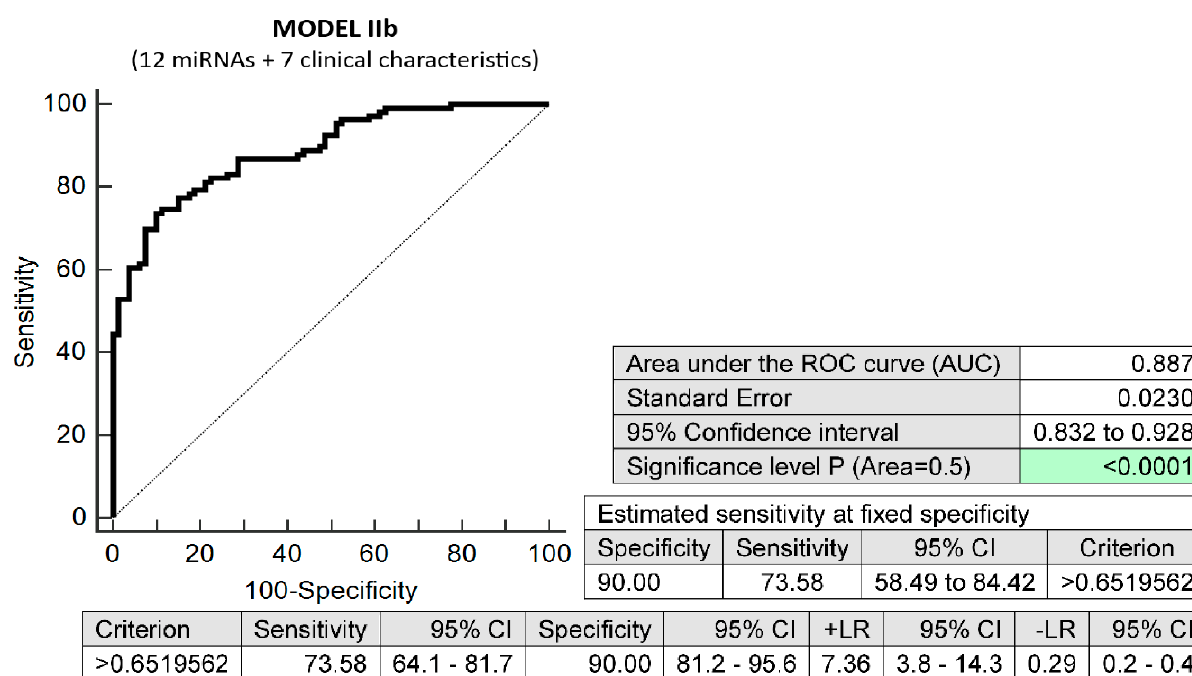
Figure 6. ROC analysis—prediction model IIb for preterm birth before 37 gestational weeks. Combination of seven maternal clinical characteristics (age and body mass index values at first trimester of gestation, treatment of infertility with techniques of assisted reproduction, preterm birth <37 gestational weeks in previous pregnancy(ies), the presence of any kind of autoimmune disease (RA, SLE, APS, T1DM, or other autoimmunity), positive first-trimester screening for early PE before 34 gestational weeks and/or FGR before 37 gestational weeks using the FMF algorithm, and positive first-trimester screening for PTB before 34 gestational weeks using the FMF algorithm) and 12 dysregulated microRNA biomarkers (miR-16-5p, miR-20b-5p, miR-21-5p, miR-24-3p, miR-